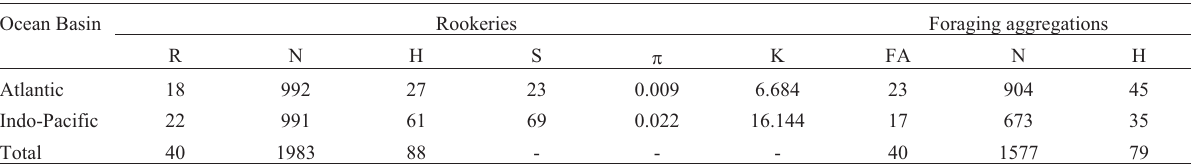
Table 1 - Dataset of haplotypes based on mitochondrial control region (739 bp) of the hawksbill turtles and genetic diversity of rookeries from Atlantic and Indo-Pacific Ocean. R: number of rookeries; N: number of individuals; H: number of haplotypes; S: number of polymorphic sites; (cid:2) : nucleotide di- versity (per site); K: average number of nucleotide differences; FA: number of foraging aggregations. Ocean Basin Rookeries Foraging aggregations R N H S